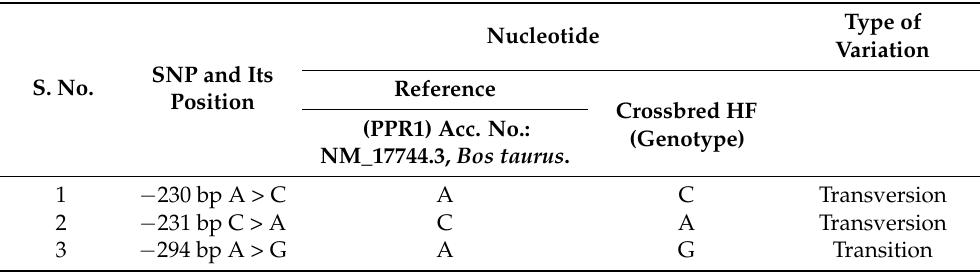
Table 4. Query sequences producing significant alignments with the top 10 species. Table 5. SNPs identified and types of mutations in bovine transferrin